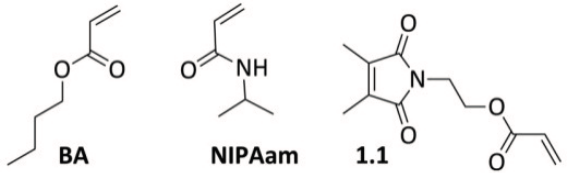
Figure 3. The monomers n -butyl acrylate (BA), N -isopropylacrylamide (NIPAam) and N -ethylacrylate-3,4-dimethylmaleimide ( 1.1